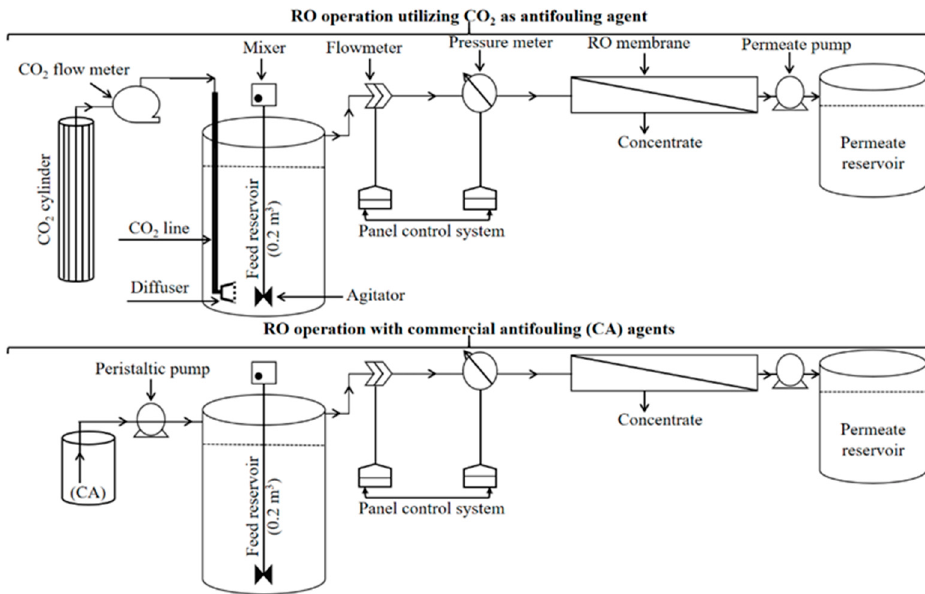
Figure 1. Schematic representation of RO schemes operated with CO 2 and commercial antifouling (CA)